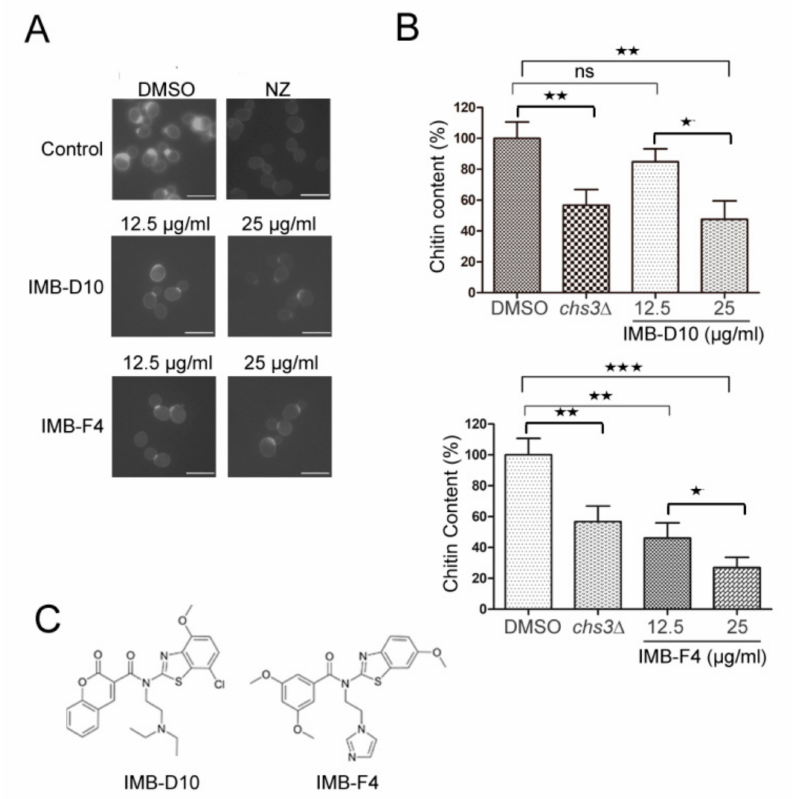
Figure 1. The chitin content in yeast cells treated with compounds IMB-D10 and IMB-F4. ( A ) WT (wild type) yeast cells were treated with IMB-D10 or IMB-F4 for 5 hours and stained with CFW (Calcofluor White M2R). An equal volume of DMSO (0.25%) or 100 µ g / mL nikkomycin Z (NZ) was added as a control. The scale bar is 5 µ M. ( B ) WT yeast cells were treated with IMB-D10, IMB-F4, or 0.25% DMSO for 16 hours at 30 ◦ C. Yeast mutant cells chs3 ∆ cultured for 16 hours were used as a negative control. The chitin content was assessed by measuring the level of D-glucosamine according to the method described by Morgan–Elson. The relative chitin content (%) in cells treated with compounds compared to that in cells treated with 0.25% DMSO was shown. All reactions were carried out in triplicate (mean ± SD; n = 3; * p < 0.05, ** p < 0.01, *** p < 0.001 and ns: no significant di ff erence). p -values were calculated with student’s t -test. ( C ) The structures of compounds IMB-D10 and IMB-F4.